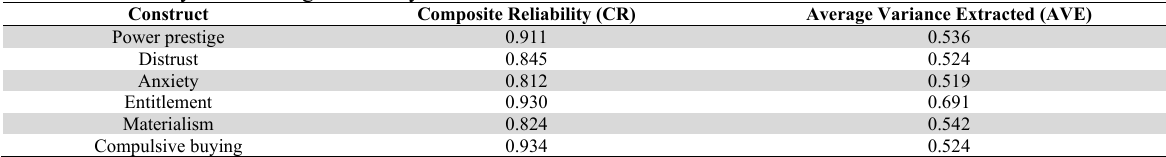
Construct reliability and convergent validity Construct